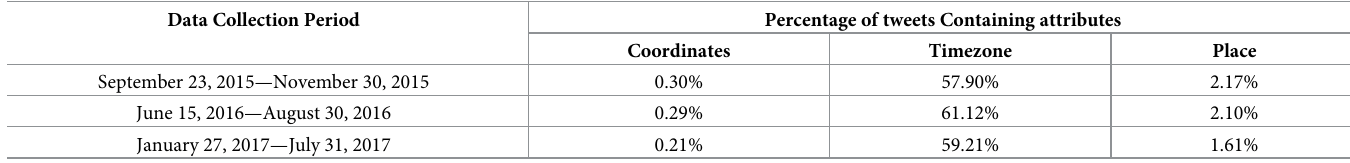
Table 2. Availability of geolocation attribute in collected Twitter Data.